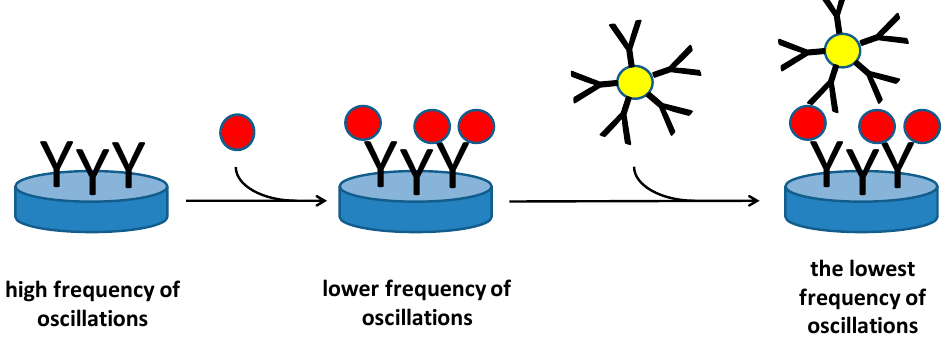
Figure 3. Piezoelectric immunosensors for the determination of an antigen (red ball) and increase of oscillations by application of a nanoparticle (yellow ball) covered with immunoglobulins (Y shaped). Blue disc represents a piezoelectric crystal.